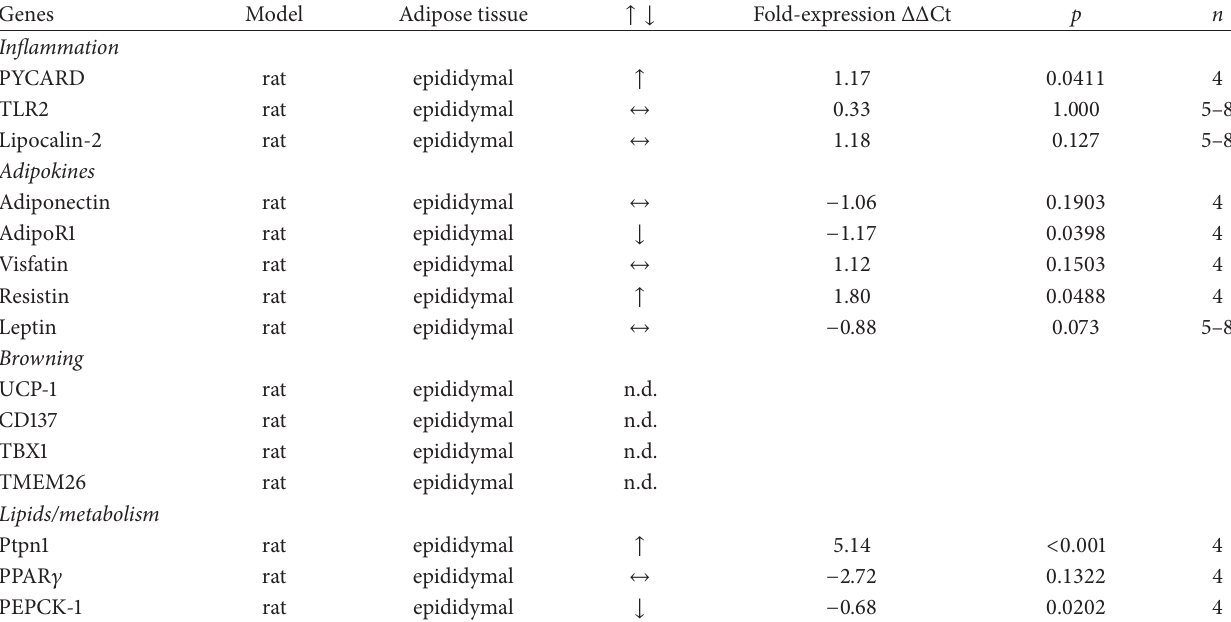
Table 1: Gene expression levels in adipose tissue from S. aureus infected endocarditis